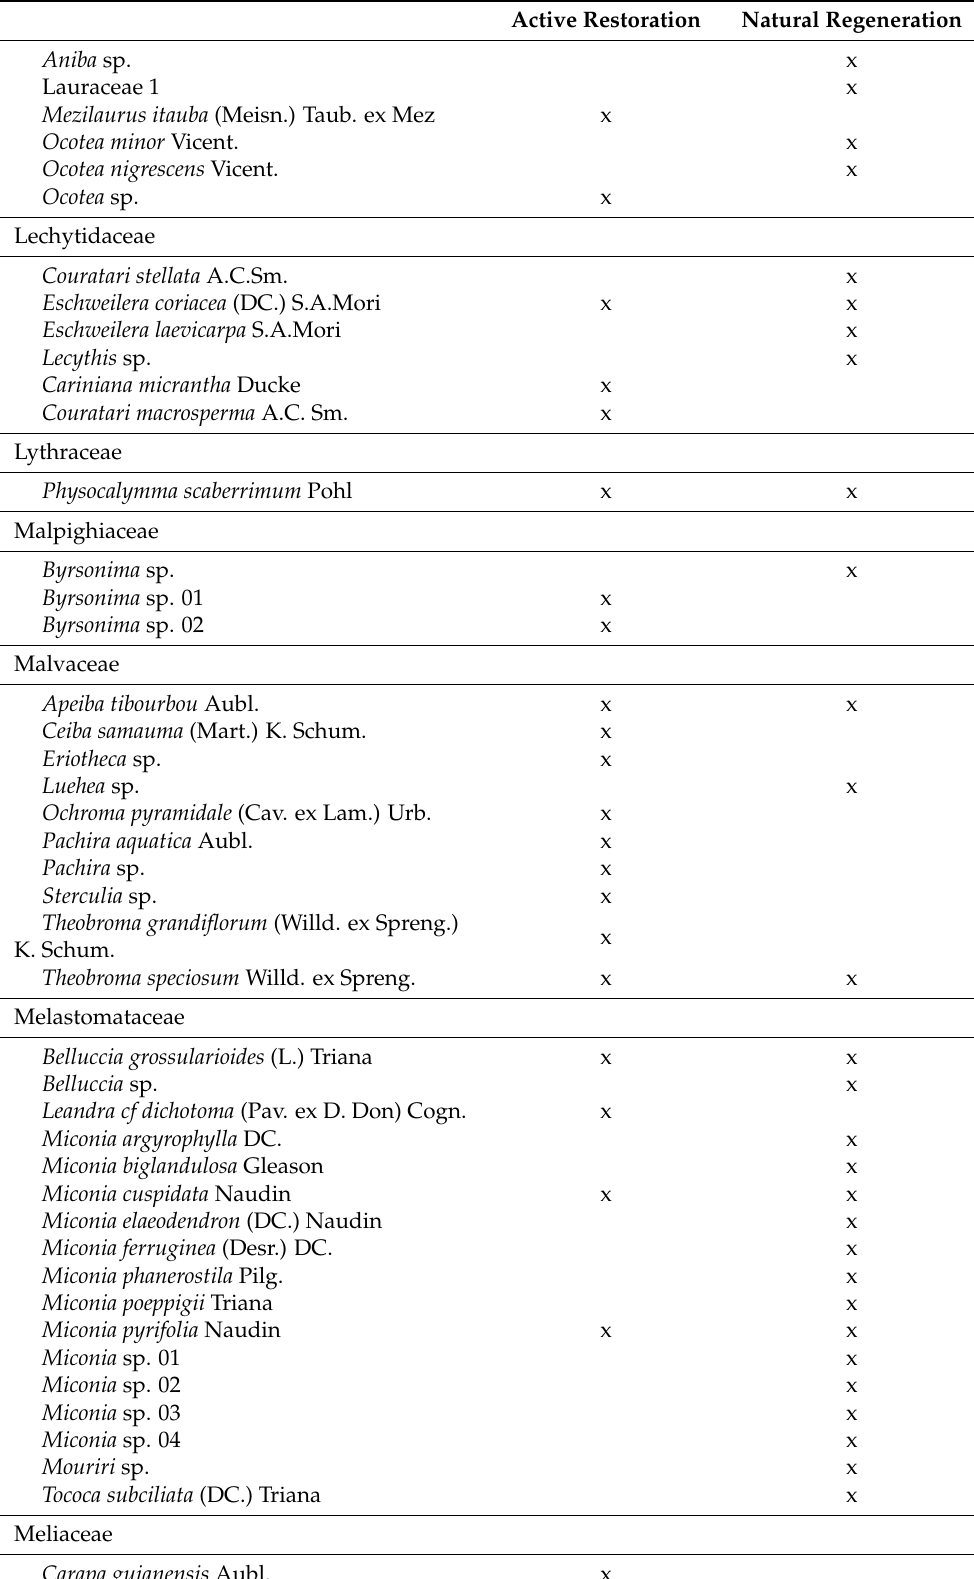
Table A2. Cont. Active Restoration Natural Regeneration Aniba sp.